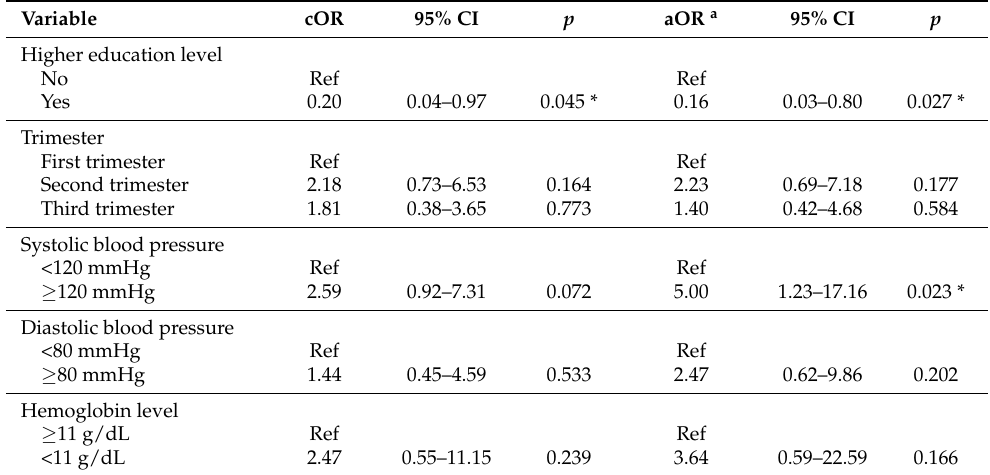
Table 5. Crude odds ratio (cOR) and adjusted odds ratio (aOR) for predictors of BLLs ≥ 5 µ g/dL ( n =